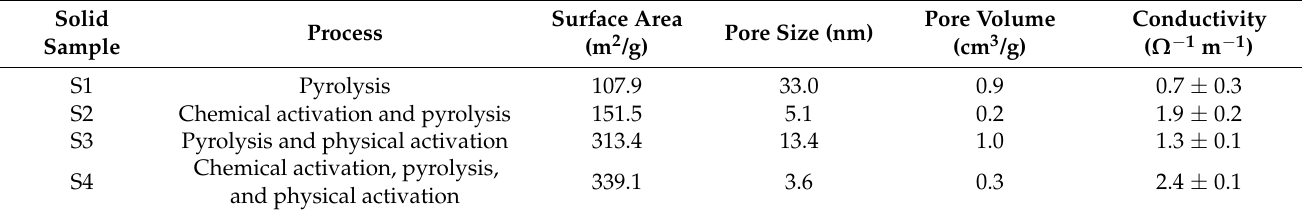
Table 3. Surface area, pore size, pore volume, and conductivity results of solid fraction from each process. Solid